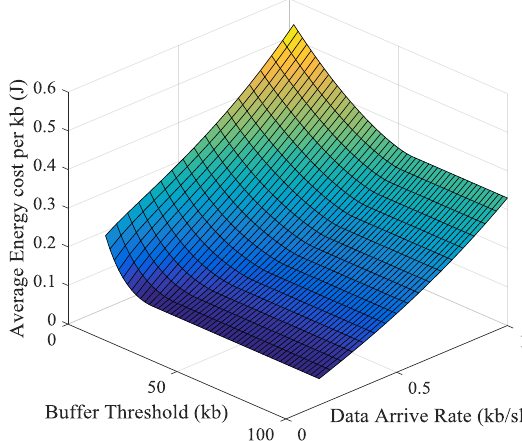
Figure 30. Theoretical results of the impact of buffer threshold and data arrival rate on the average energy cost.